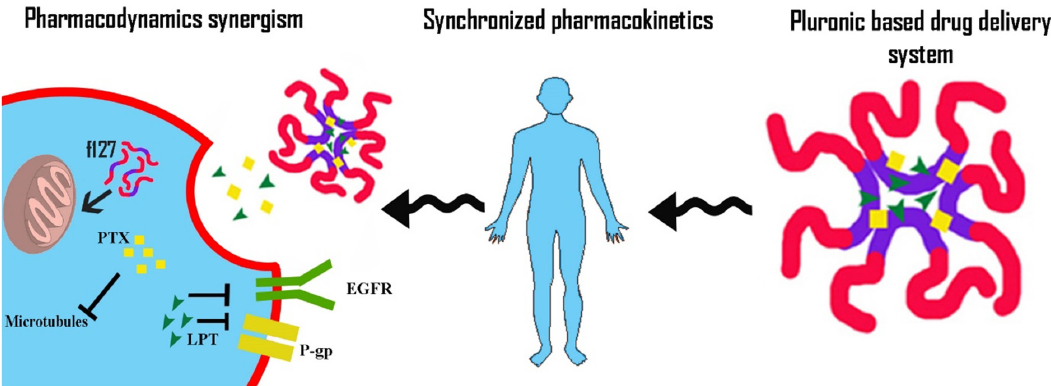
Fig. 2. Paclitaxel- lapatinib loaded pluronic micelle; a combined pluronic based delivery system Table 2. Pluronic based combinational delivery systems with multiple payloads Drug delivery